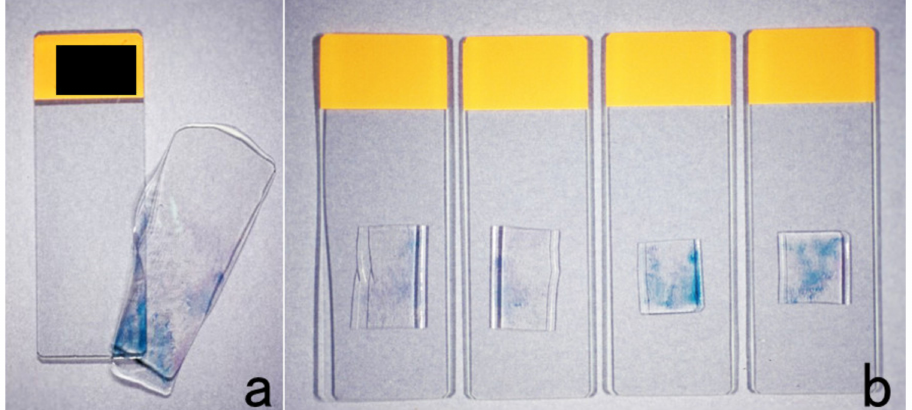
Figure 58. The cell transfer technique. After removal of the cover glass, the cell preparation is covered with mounting resin solution that solidifies to become a thick membrane sheet. Cells are transferred to the solidified resin ( a ). After cutting the resin membrane into several pieces, they are placed onto silane-coated glass slides, which should be fully dried in an incubator ( b ). The resin component can easily be removed by dipping the specimens in xylene. Now, the specimens are ready for immunostaining using